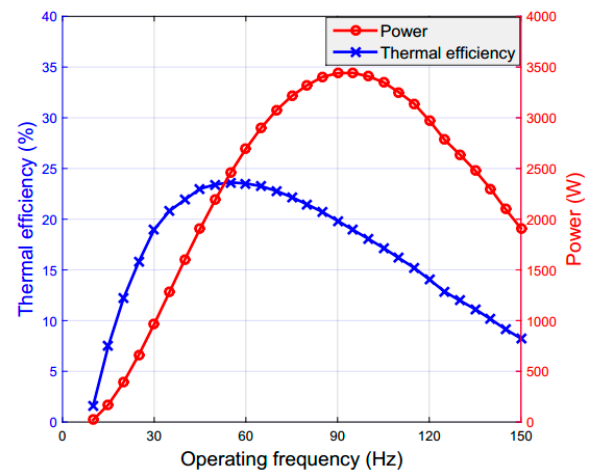
Figure 20. Thermal performances of MSRE at different frequencies.